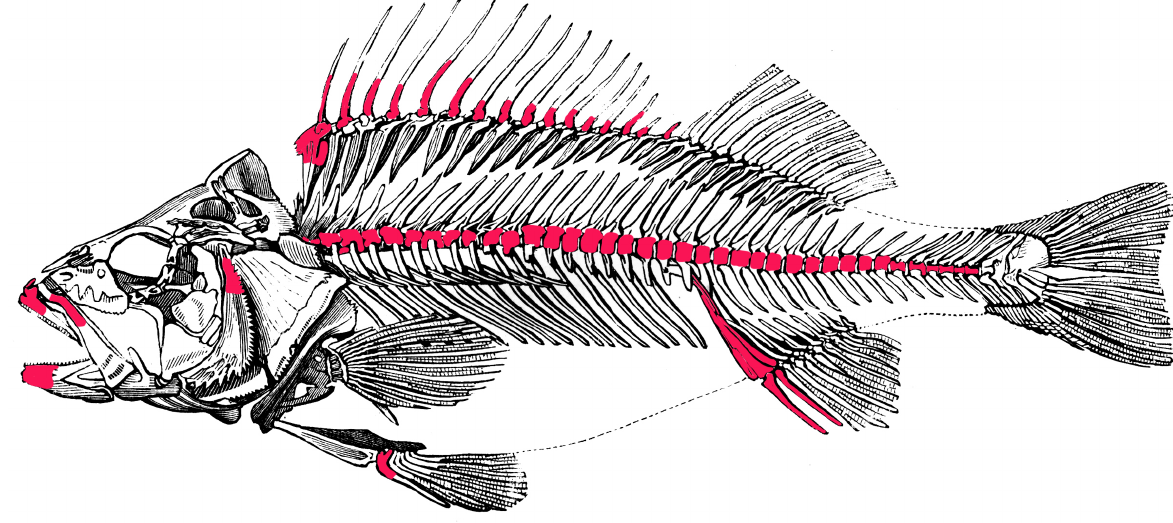
Figure 2. Sketch drawing of the skeleton of the common perch ( Perca fluviatilis ) representing a generalized percomorphacean. Shaded in red the elements here reported. Modified from Goodrich (1859).